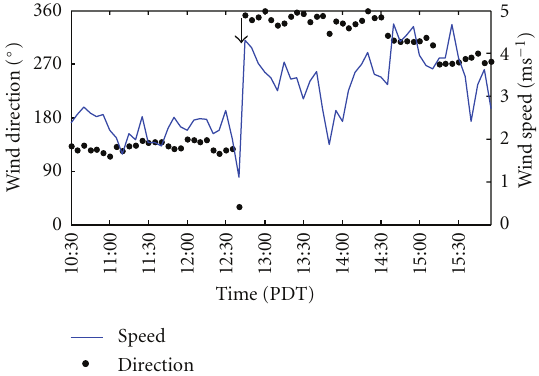
Figure 5: Time series of 5min averaged wind speed and direction at the interior tower. Timing of fire whirl is indicated with solid